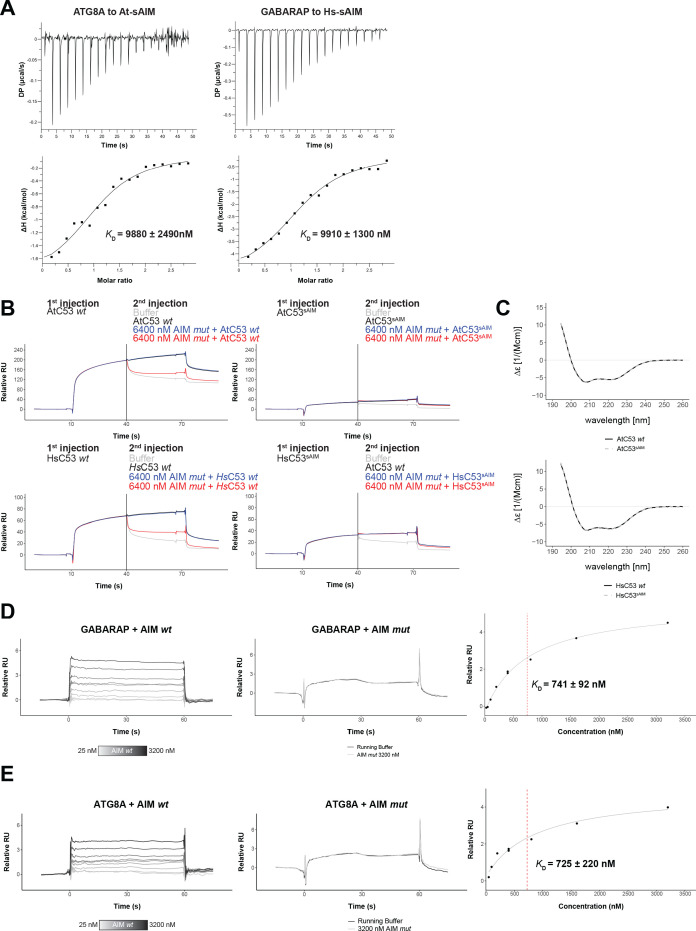
Biophysical characterization of sAIM mediated C53-ATG8 interaction.(A) Isothermal titration calorimetry (ITC) experiments showing binding of At-sAIM and Hs-sAIM peptides to ATG8A and GABARAP, respectively Upper left and right panels show heat generated upon titration of At-sAIM (EPLDFDIDWDLEEEM) (600 µM) or Hs-sAIMC53 (EPLDFDIDWGLEEEM) (600 μM) to ATG8A or GABARAP (both 40 μM). Lower left and right panels show integrated heat data (■) and the fit (solid line) to a one-set-of-sites binding model using PEAQ-ITC analysis software. Representative values of KD, N, ΔH, -TΔS and ΔG from three independent ITC experiments are reported in Supplementary file 6. (B) AtC53 and HsC53 sAIM mutants do not interact with ATG8A or GABARAP, respectively. Upper Panels, GST-ATG8A or Lower Panels, GST-GABARAP were captured on the surface of the active cell (500 RU) and GST was captured on the surface of the reference cell (300 RU). The two flow cells were exposed to the ligands Upper left AtC53, Upper right AtC53sAIM, Lower Left, HsC53 and Lower right, HsC53sAIM with four sets of double consecutive injections (1st set: 10 µM ligand, running buffer; 2nd set: 10 µM ligand, 10 µM ligand; 3rd set: 10 µM ligand, 10 µM ligand + 6.4 µM AIM wt peptide; 4th set: 10 µM protein, 10 µM protein + 6.4 µM AIM mut peptide). Binding curves were obtained by subtracting the reference cell from the active cell. A representative sensorgram from two independent experiments is shown. (C) AtC53sAIM and HsC53sAIM mutants have similar secondary structure compared to AtC53 and HsC53, respectively. Upper Panel, Far-UV circular dichroism (CD) spectra of AtC53 wt (black line) and its variant AtC53sAIM (grey dashed line). Lower Panel, Far-UV circular dichroism (CD) spectra of HsC53 wt (black line) and its variant HsC53sAIM (grey dashed line). (D) Quantification of the binding affinity of AIM wt to GABARAP. GST-GABARAP fusion protein was captured on the surface of the active cell (500 RU) and GST was captured on the surface of the reference cell (300 RU). Representative sensorgrams from at least three independent experiments are shown. Left Panel, Multi-cycle kinetics experiment with increasing concentrations of the AIM wt peptide. Binding curves were obtained by double referencing (i.e. reference cell signal subtracted from active cell signal; subtraction of buffer injection). 400 nM*=Internal replicate. Center Panel, Injection of running buffer (grey) and 3600 nM AIM mut peptide (black). Right Panel, Plot of steady-state response units versus the respective concentration of the AIM wt peptide, which was used to determine the dissociation constant KD. (E) Quantification of the binding affinity of AIM wt to ATG8A. GST-ATG8A fusion protein was captured on the surface of the active cell (500 RU) and GST was captured on the surface of the reference cell (300 RU). Representative sensorgrams from at least three independent measurements are shown. Left Panel, Multi-cycle kinetics experiment with increasing concentrations of the AIM wt peptide. Binding curves were obtained by double referencing (i.e. reference cell signal subtracted from active cell signal; subtraction of buffer injection). 400 nM*=Internal replicate. Center Panel, Injection of running buffer (grey) and 3600 nM AIM mut peptide (black). Right Panel, Plot of steady-state response units versus the respective concentration of the AIM wt peptide which was used to determine the dissociation constant KD.